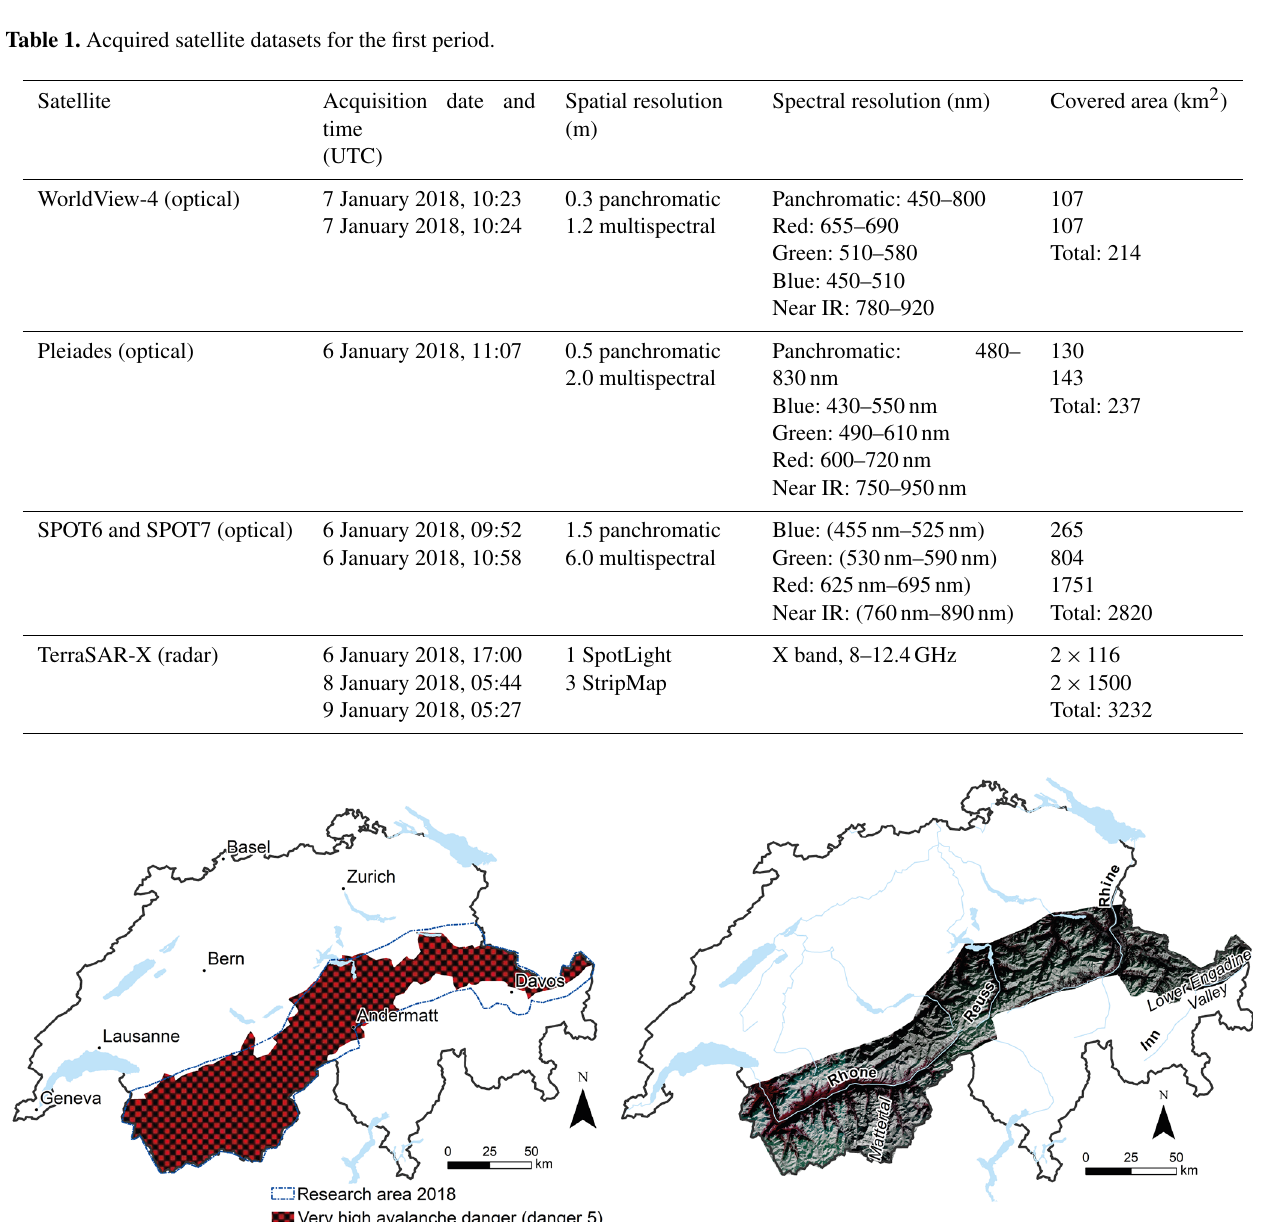
Figure 1. Study area and forecasted very high avalanche danger and overview of the acquired SPOT6 dataset (SPOT6 data ©Airbus DS 2018) acquired for period